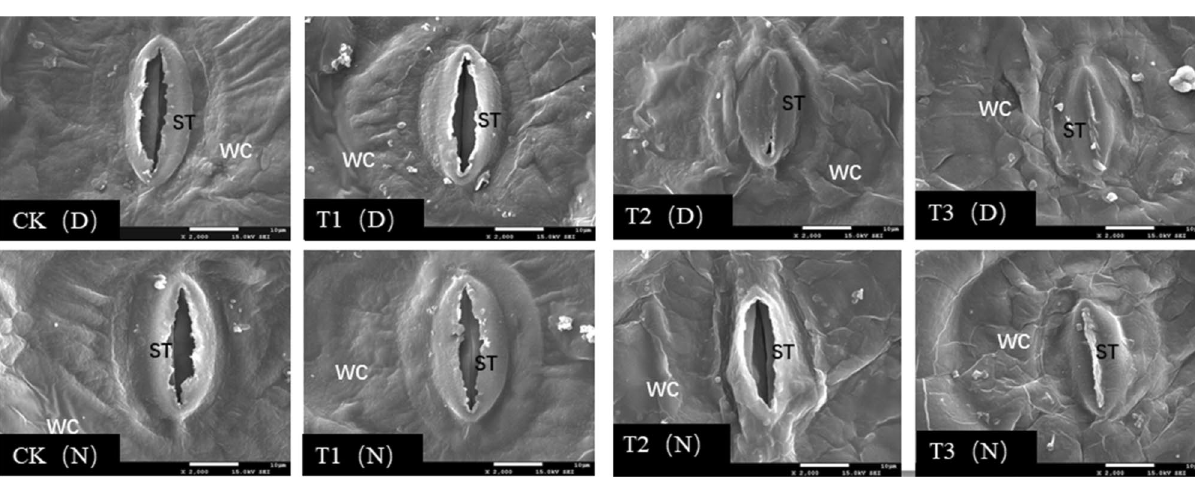
Figure 9. Scanning electron micrographs of Phedimus aizoon L. leaves under drought stress (× 2000). ST, stoma; WC, wax coat; D, daytime (11:00 a.m.); N, nighttime (11:00 a.m.).